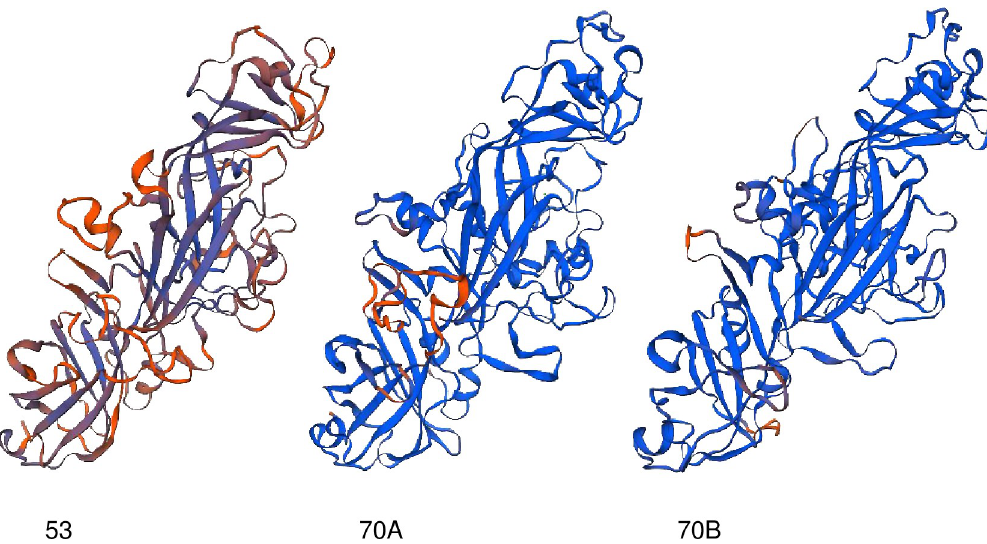
Fig 4. Protein structure homology-modeling of Mfa1. The mature form of the amino acid sequences of genotypes 53 (Ando), 70A (ATCC 33277), and 70B (JKG9) were subjected to SWISS-MODEL analysis. Homology modeling was performed using Mfa1 of ATCC 33277 (5nf3.1.A in PDB) as a template. The quality of protein structure models is indicated by qualitative model energy analysis (QMEAN): blue and red indicate good and bad specific feature quality scores,